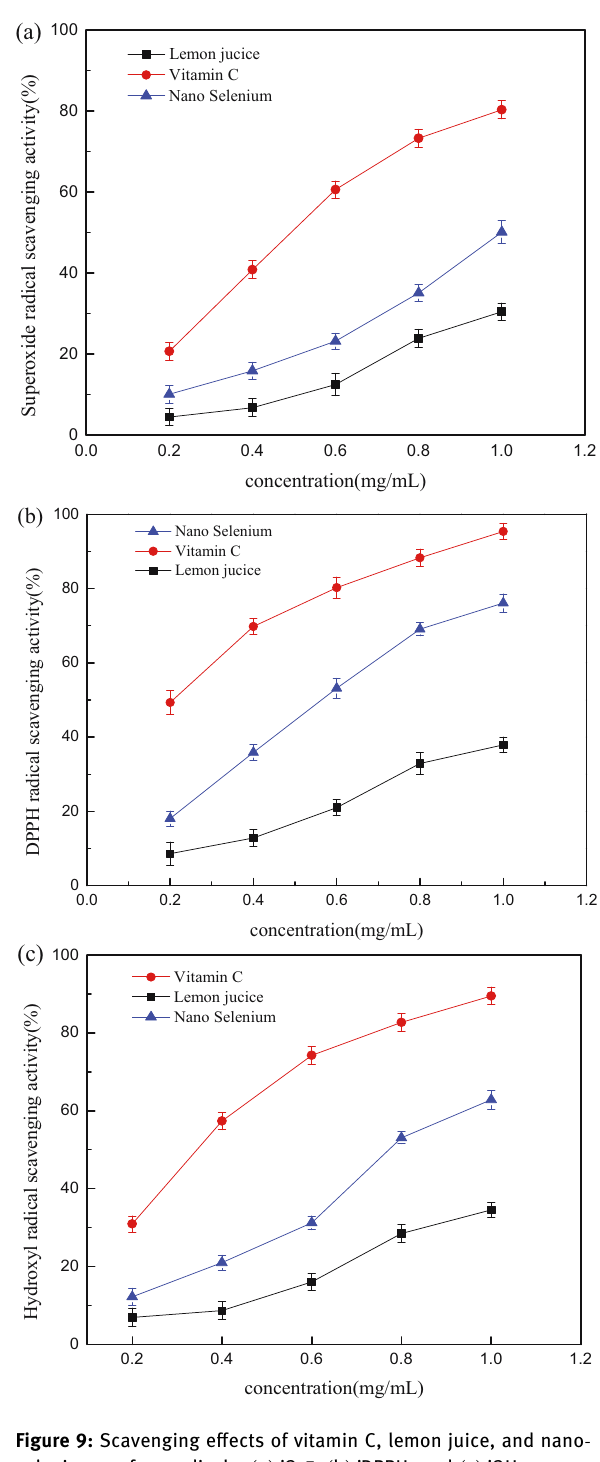
Figure 9: Scavenging e ff ects of vitamin C, lemon juice, and nano - selenium on free radicals: ( a ) ˙ O 2 − , ( b ) ˙ DPPH, and ( c ) ˙ OH.